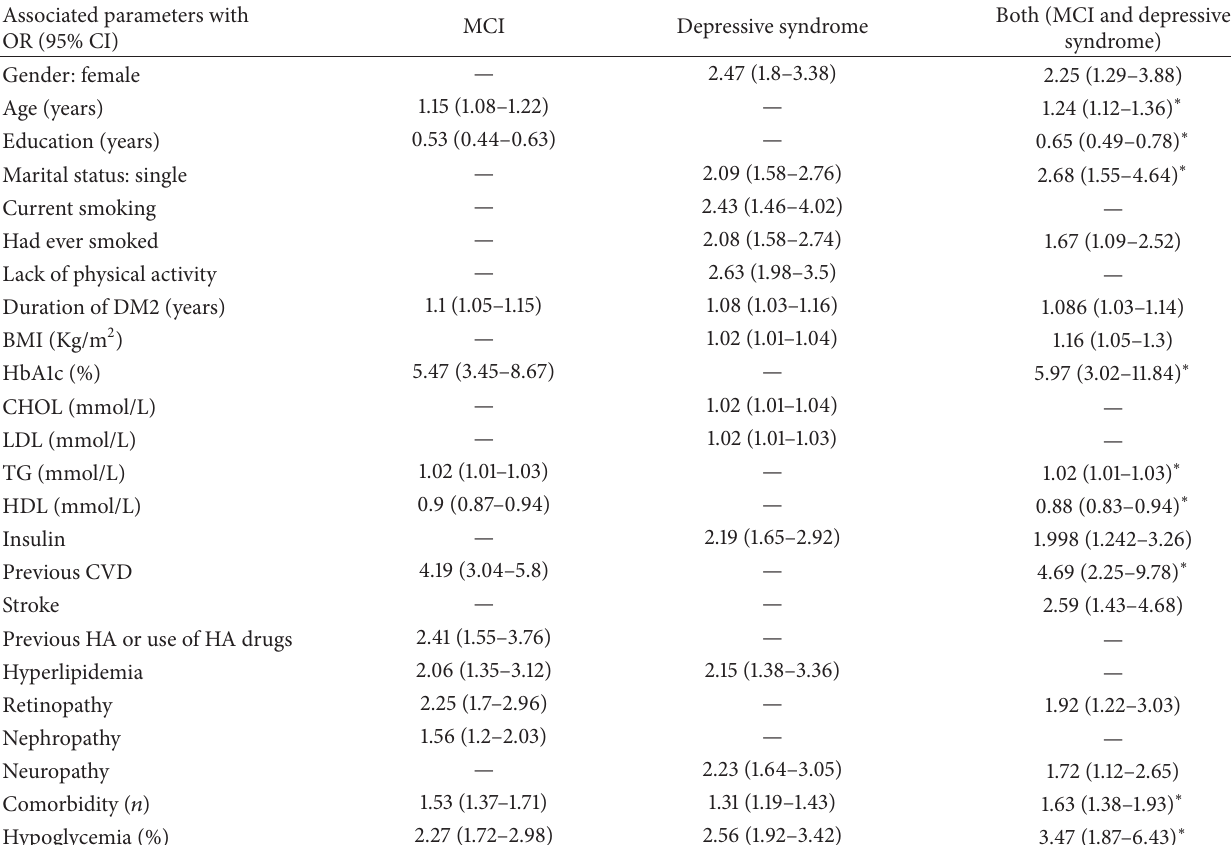
Table 2: Factors associated with MCI, depressive syndrome, and both (univariate logistic regression model). Associated parameters